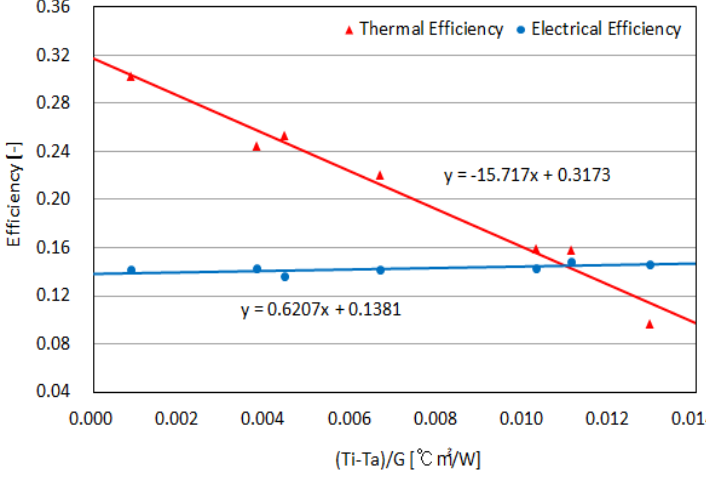
Figure 2. Thermal and electrical efficiency of the air ‐ type PVT collector for the heat recovery ventilator (HRV) system.